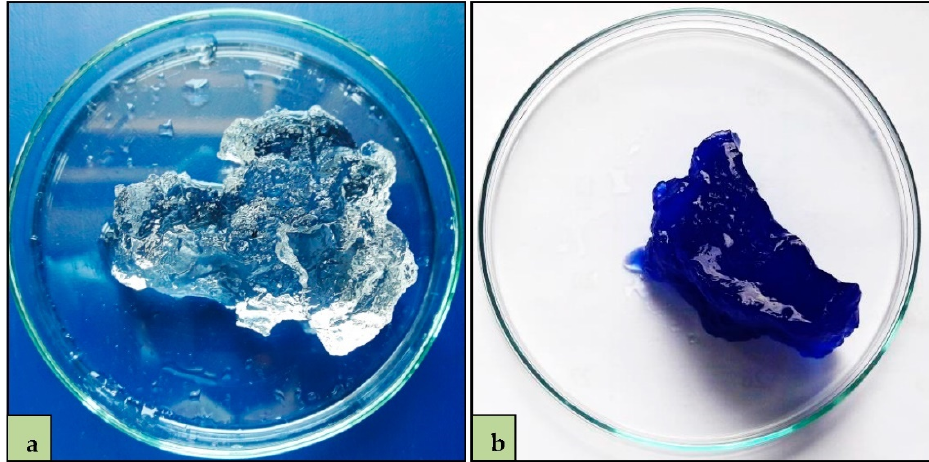
Figure 3. SAP-AC hydrogel after 24 h ( a ) in water and ( b ) in 50 ppm MB solution.